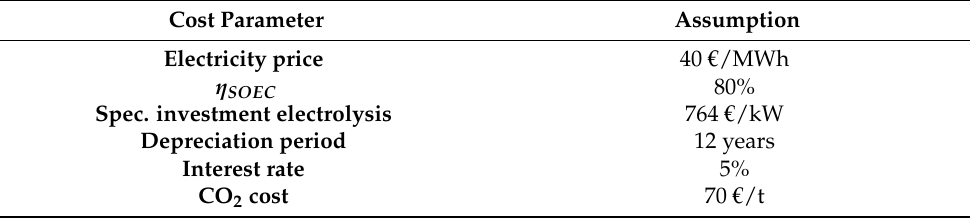
Table 8. Assumptions for the base